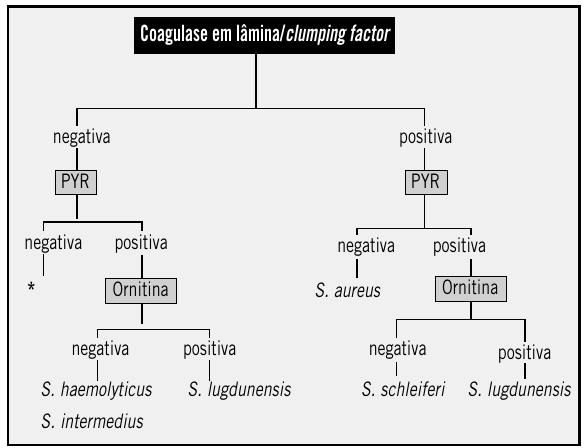
Figura 1 – Fluxograma de identificação simplificada de S. lugdunensis. Adaptado de POUTANEN, S. M.; BARON, E. J. Staphylococcus lugdunensis: a notably distinct coagulase-negative Staphylococcus. Clinical Microbiology Newsletter, v. 23, n. 19, p. 147-50,